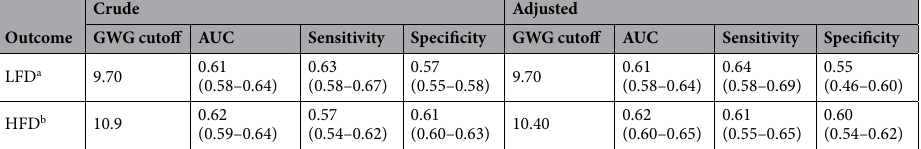
Table 3. Area under the ROC curve (AUC) and Sensitivity, specificity for at the optimal cutoff point in Normal weight. 18.5 ≤ BMI < 25 kg/m 2 (n = 4998). a Adjusting for age, cesarean section, and smoking. b Adjusting for age and cesarean